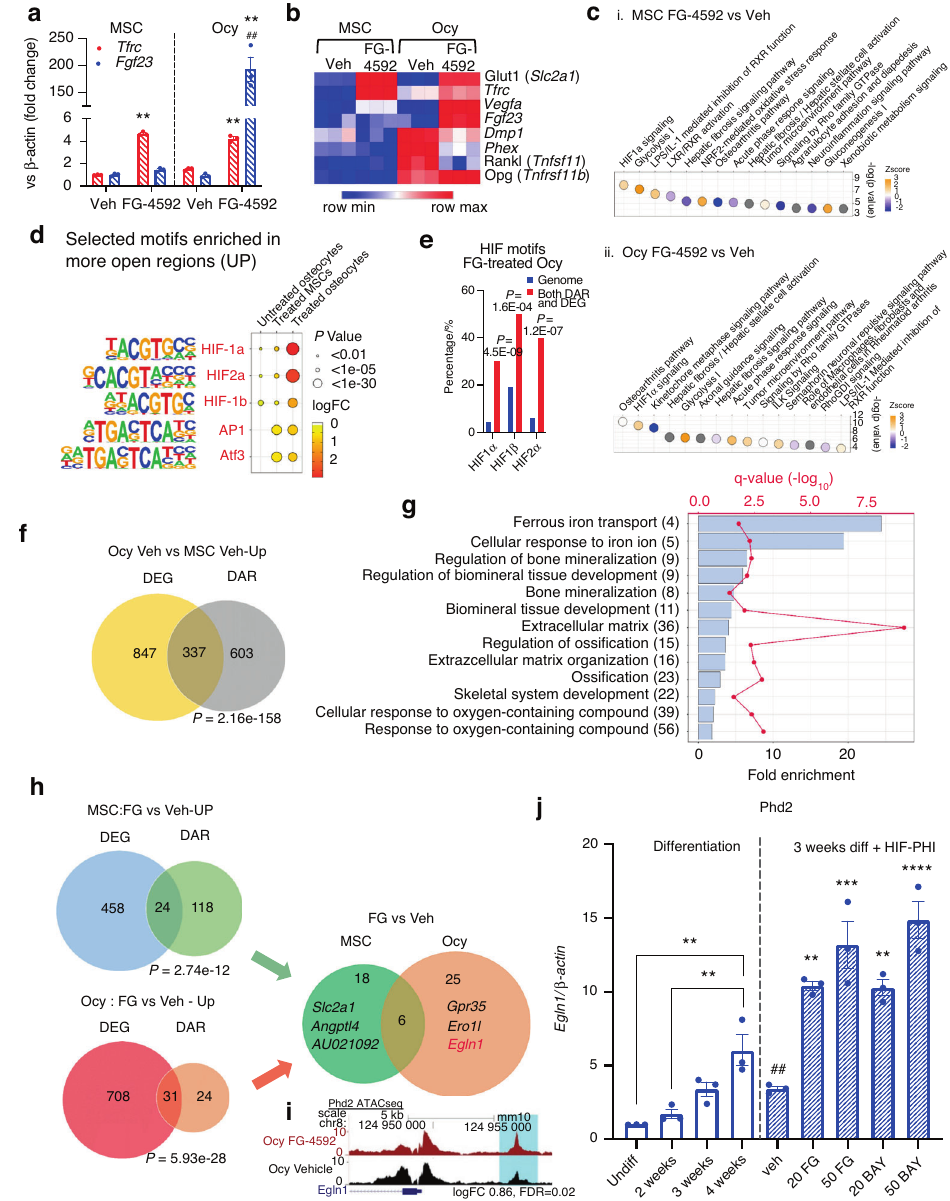
Fig. 2 Osteocytes respond to HIF-PHI on the genomic level. a Transferrin receptor ( Tfrc ; red) and Fgf23 (blue) mRNA expression was measured in mesenchymal stem cells (MSC; undifferentiated MPC2 cells) and osteocytes (Ocy; 3-week differentiated MPC2 cells) treated with vehicle or 50 μ mol·L − 1 FG-4592 for 48 hours (** P < 0.01 vs. veh; ## P < 0.01 vs. MSC, same treatment). b RNAseq heat map of speci fi c HIF-responsive genes and selected genes involved in mineralization and bone turnover in untreated and treated MSC and Ocy. c.i Top 15 Canonical Pathways identi fi ed in RNAseq data by Ingenuity Pathway Analysis in FG-4592-treated MSC compared to vehicle-treated MSC and c.ii FG-4592-treated Ocy compared to vehicle-treated Ocy (orange Z-score indicates predicted pathway activation and blue indicates predicted pathway inhibition). d Selected motifs, including HIF motifs, enriched in more open regions of the genome in treated Ocy compared to treated MSC or untreated Ocy by ATACseq. e Integration of RNAseq and ATACseq showed signi fi cant enrichment of HIF motifs in more open regions of the genome associated with gene upregulation compared to the entire genome. f Venn diagram of differentially expressed genes (DEG) and differentially accessible regions (DAR) that overlap in Ocy vs. MSC, identifying 337 genes that have more chromatin within − 10 kb of the TSS and have upregulated gene expression. g Gene Ontology (GO) Biological Processes enriched in Ocy compared to MSC (numbers in parenthesis are gene count). h Venn diagrams of differentially expressed genes (DEG) and differentially accessible regions (DAR) in FG-4592-treated MSC vs. vehicle-treated MSC and FG-4592-treated Ocy vs. vehicle-treated Ocy, identifying 24 and 31 genes, respectively, that have more chromatin within − 10 kb of the TSS and have upregulated gene expression. Of these genes in each cell type, 6 overlapped, whereas 25 genes were unique to Ocy. Among the top 3 genes in Ocy was Egln1 (encodes Phd2), a gene involved in oxygen sensing, and was thus examined further. i Representative ATACseq peaks of FG-4592-treated osteocytes (top track; crimson) compared to vehicle-treated osteocytes (bottom track; black). Highlighted in blue is the more open peak at − 5 700 bp from the TSS of the Phd2 ( Egln1 ) gene. j Phd2 expression across MPC2 cell osteogenic differentiation (** P < 0.01 vs. undifferentiated